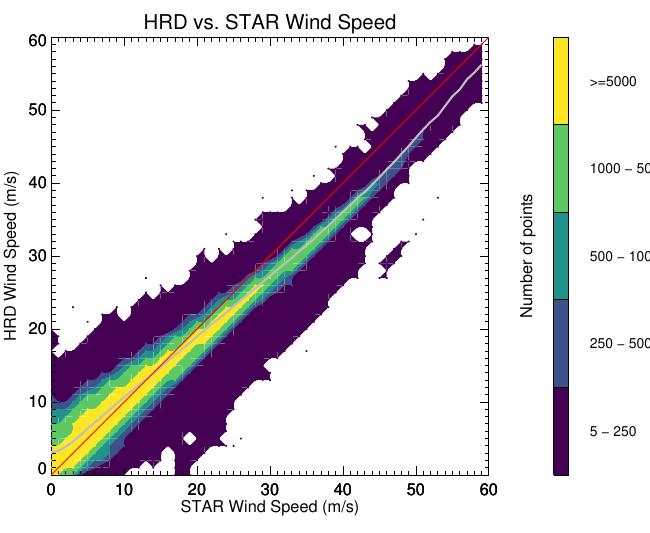
Figure 10. Two-dimensional histogram of the HRD wind speed vs. wind speed produced by the model developed in this manuscript from all collocated data available. The solid gray line shows the mean in each 1ms − 1 bin on the horizontal axis. The solid red line is the y = x